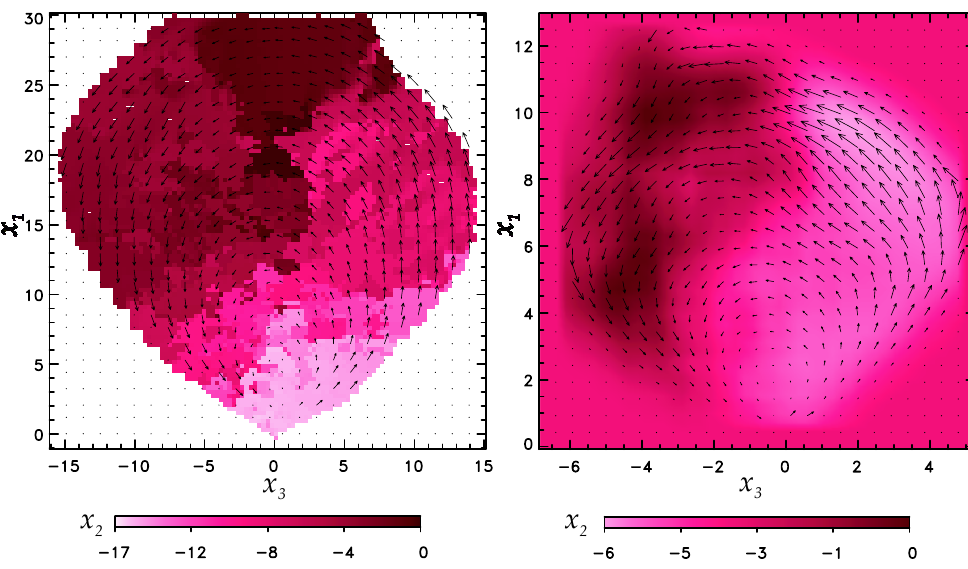
Fig. 9. The coherent dynamics in three-dimensional subspace spanned by the leading principal components of vB S − AL covariance matrix. (a) The dynamical manifold is derived with the use of the two-dimensional distribution function ρ(x 1 ,x 3 ) calculated for the whole Bargatze et al. (1985) database with NN = 300. The points of the surface are associated with the maxima of the conditional probability function ρ(x 2 | x 1 ,x 3 ) ∼= ρ(x (k) ) . (b) Smoothed dynamical manifold calculated for the first 20 intervals of Bargatze et al. (1985) database by Sitnov 2 et al.